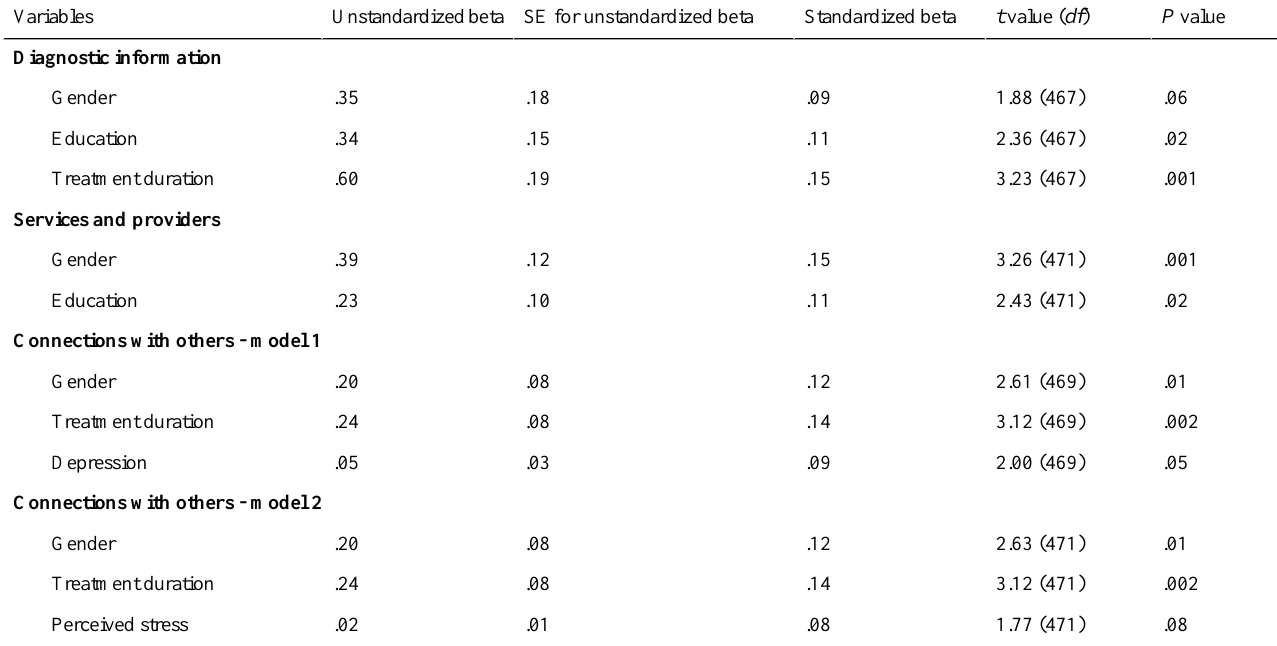
Table 3. Regression analysis summary for participant characteristics associated with searching for diagnostic information, services and providers, and connections with